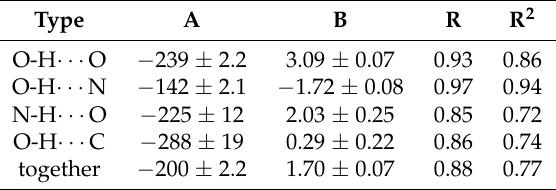
Table 5. Linear fit parameters for the linear relation E HB = A ρ BCP + B between the hydrogen bond energy (in kcal/mol) and electron density at the BCP (au) of the indicated hydrogen bond